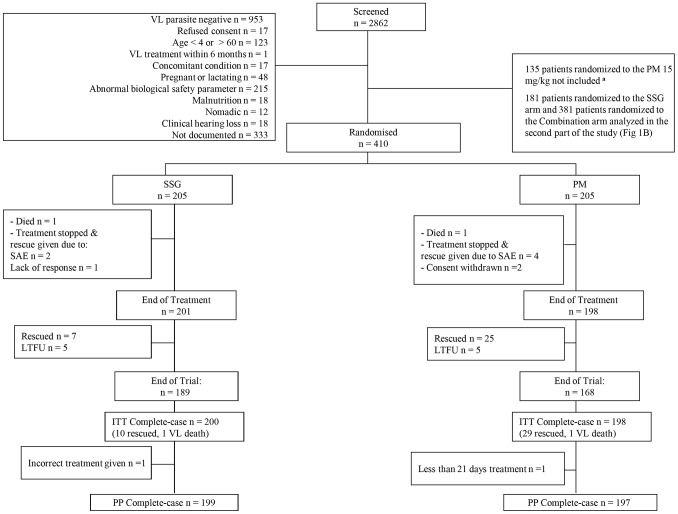
CONSORT Patient Flowchart – SSG vs. PM.SSG, sodium stibogluconate; PM, paromomycin sulphate; SAE, serious adverse event; LTFU, loss to follow-up; ITT, intention-to-treat; PP, per protocol. Patients included in the SSG (20 mg/kg/day for 30 days) vs. PM (20 mg/kg/day for 21 days) arms; a data from these patients were previously reported [14].